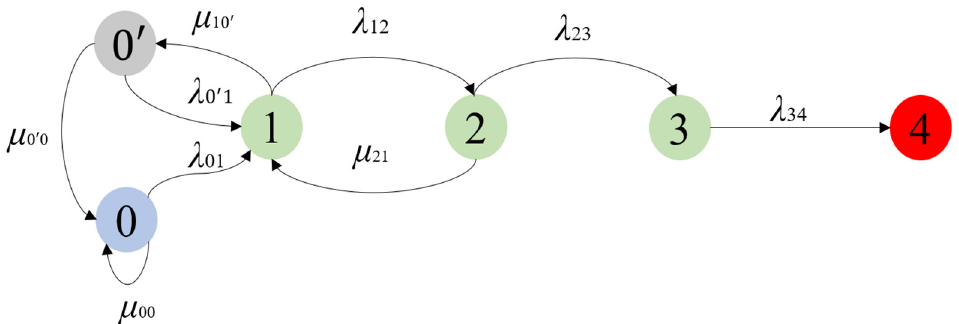
Figure 1. State transition diagram (0: initial state, 0 ′ : double branches, 1: one-block lead, 2: two-block lead, 3: three-block lead, and 4: attack success).